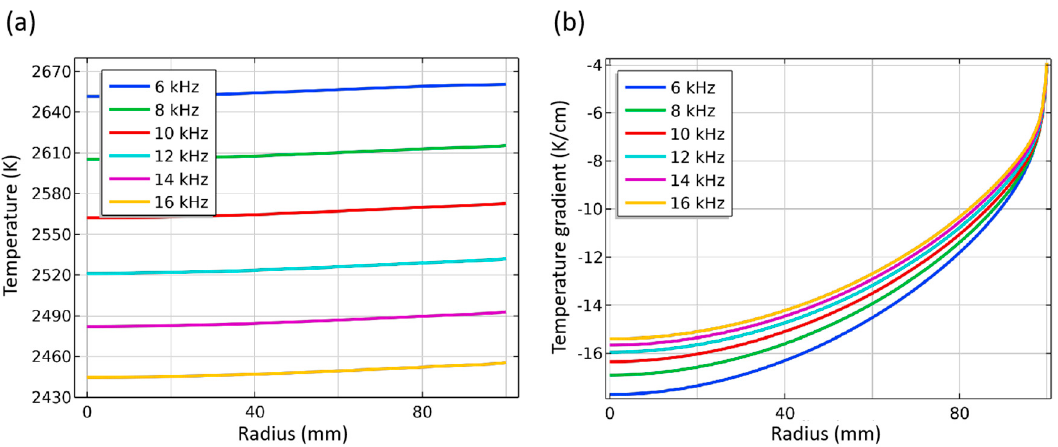
Figure 8. Temperature and temperature gradient at different frequency. ( a ) Temperature along sur- face of seed crystal; ( b ) Temperature gradient around seed